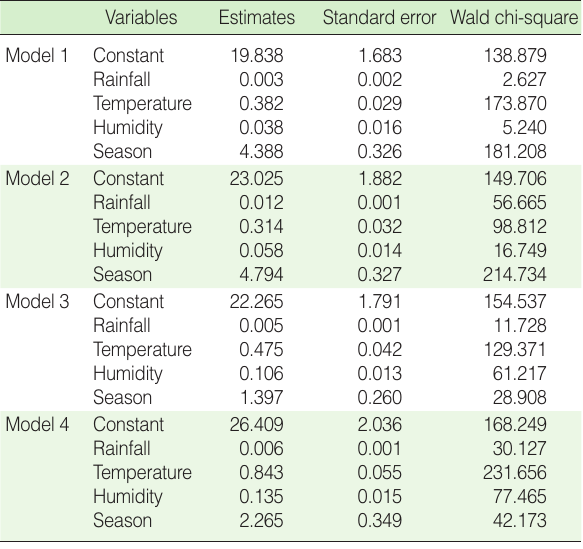
Table 4. Models based on a negative binomial generalized linear model relating the monthly number of dengue cases with the rain- fall, temperature, relative humidity, and